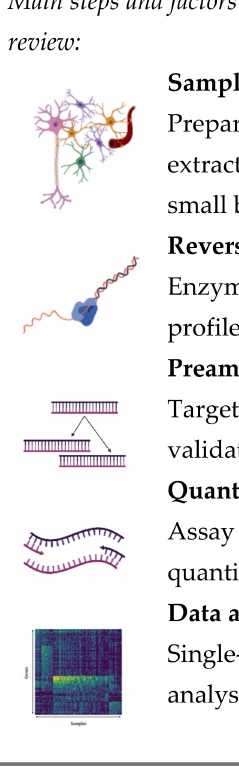
Figure 1. scRT-qPCR